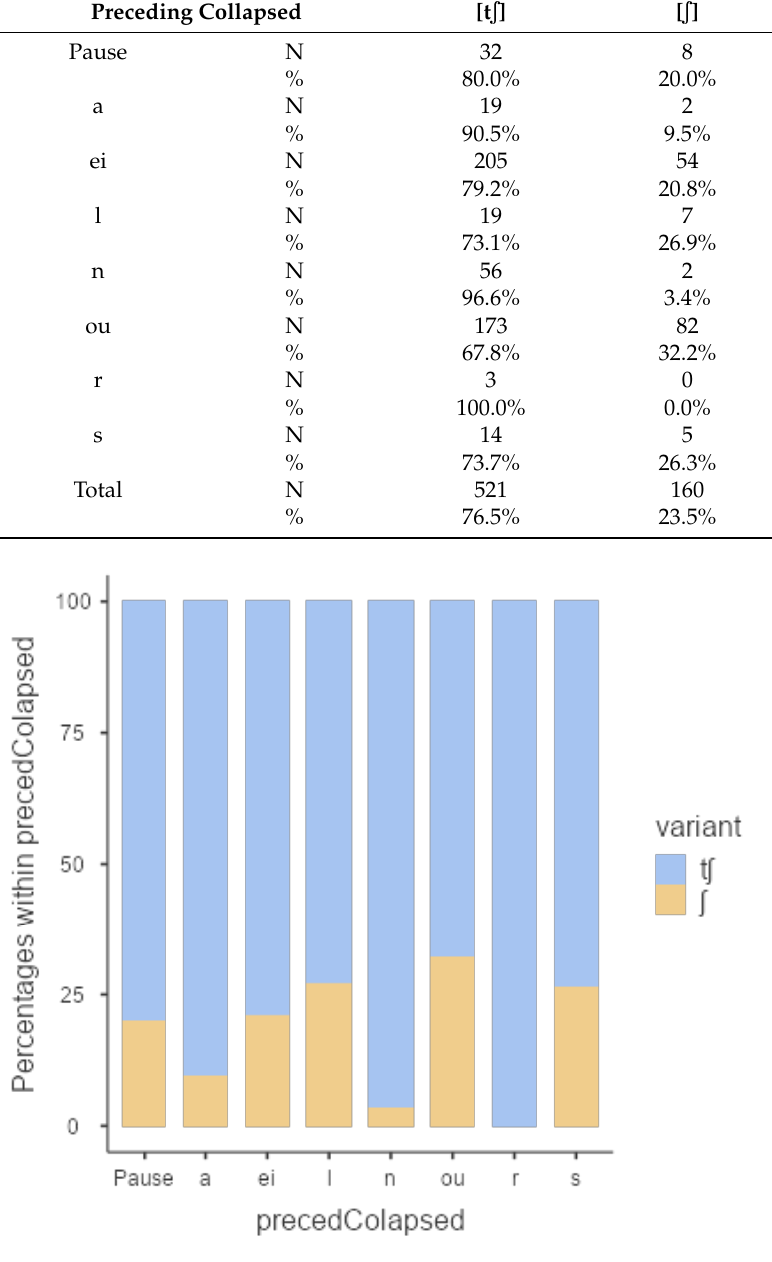
Figure A1. Distribution of [t ʃ ] and [ ʃ ] by preceding context.